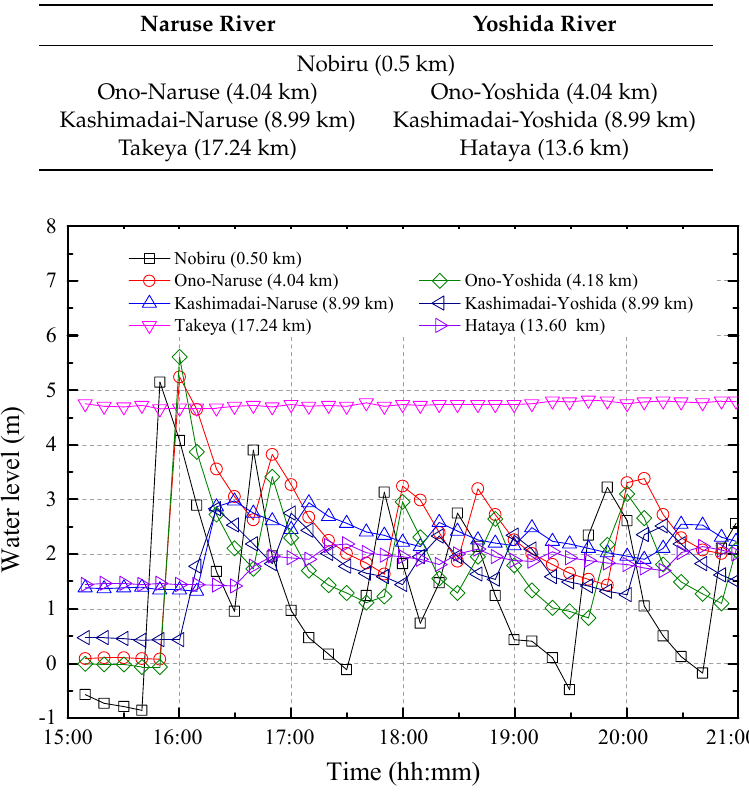
Figure 9. ( a ) Location of water level measuring stations along Naruse and Yoshida Rivers; ( b ) Naruse River mouth morphology. Table 1. Measuring stations of water level along Naruse and Yoshida Rivers. The number in () refers to the distance from the river mouth.